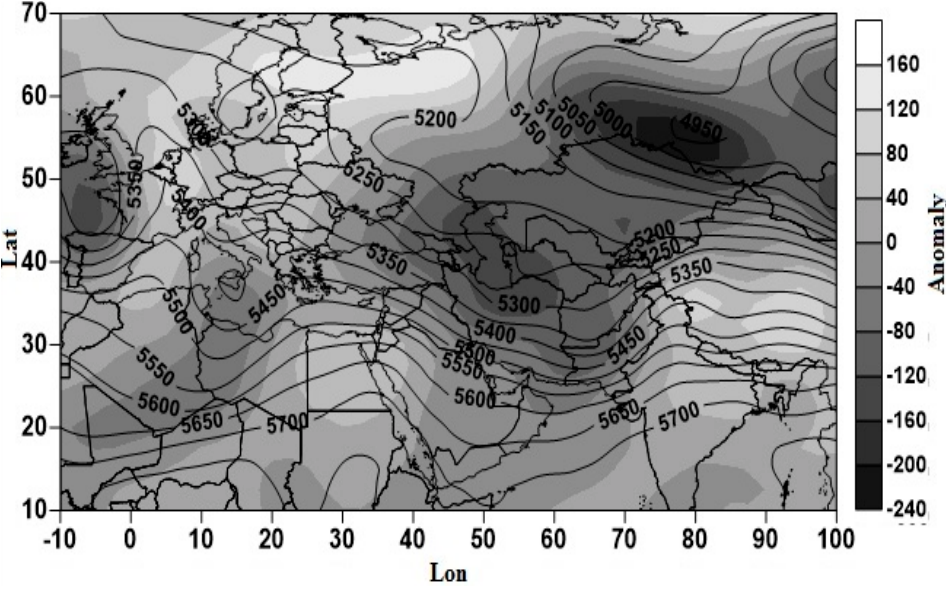
Figure 5. Anomalies and atmosphere thickness (in meters) for the representative day of the second pattern.